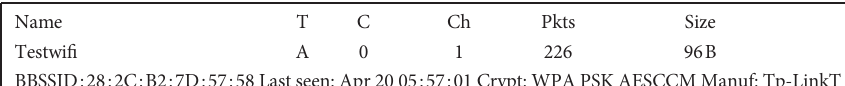
Figure 6: Kismet scan target AP results.